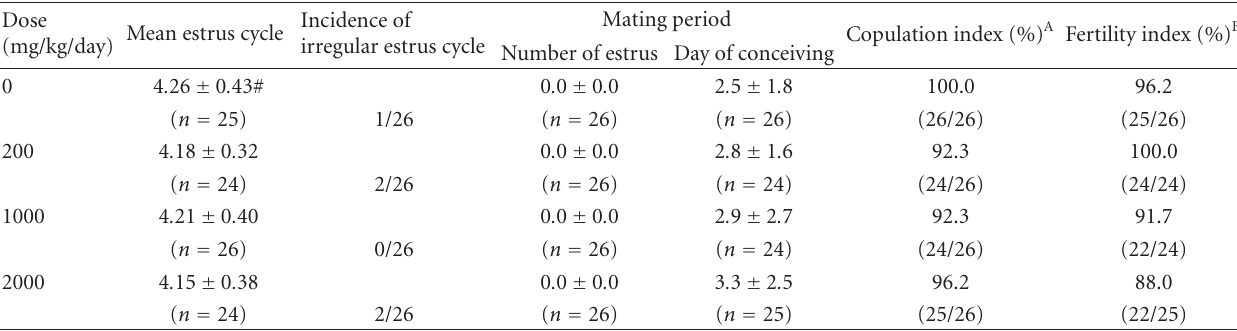
Table 5: E ff ect of SE5-OH administration on the reproductive performance of the F 0 generation rat dams. Incidence of Dose Mean estrus cycle irregular estrus (mg/kg/day)